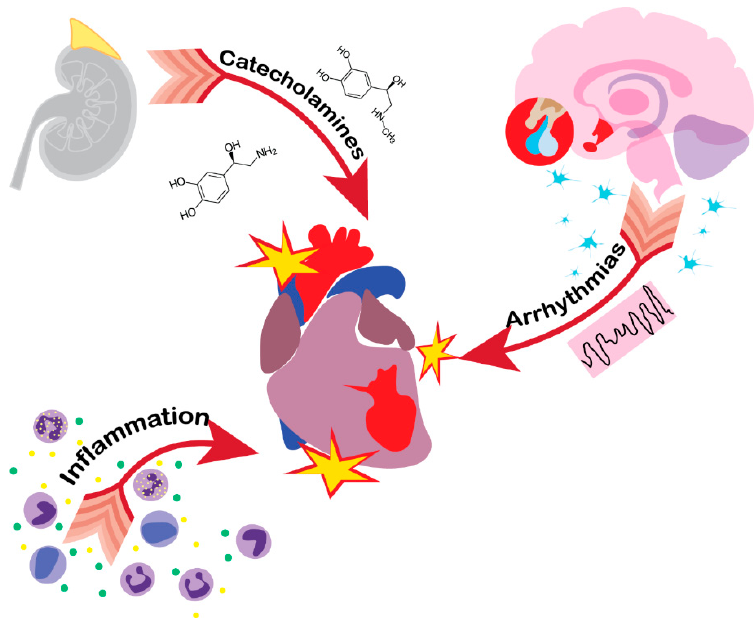
Figure 2. Pathological pathways of heart injury in acute brain damage patients. Catecholamine surge, inflammation and HPA axis imbalance are the leading causes of heart dysfunction following brain injury, which may manifest in Tako-tsubo cardiomyopathy.